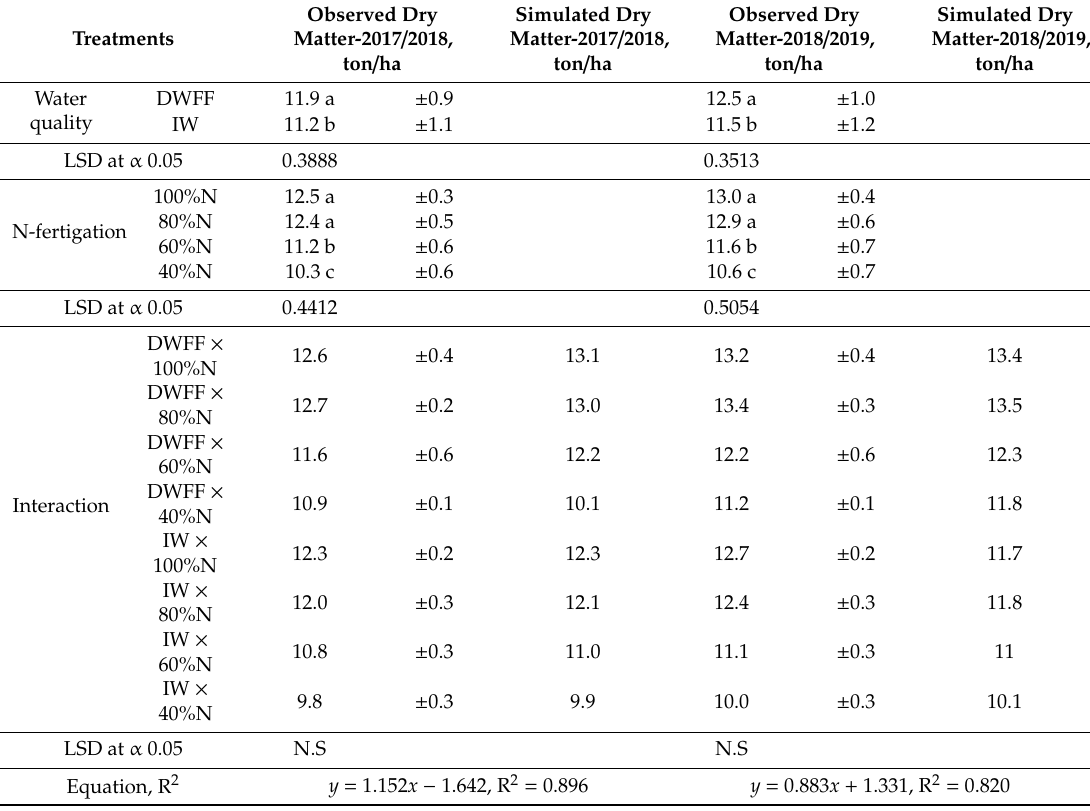
Table 8. E ff ect of water quality and nitrogen fertigation on the average weight of barley dry matter and compares it to simulated barley dry matter for all